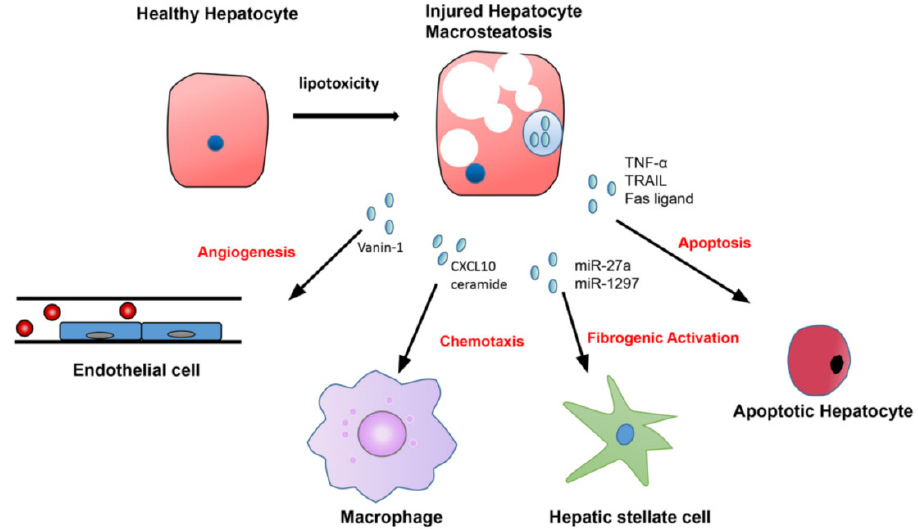
Figure 4. Lipotoxic hepatocytes release numbers of EVs containing specific cargo that contribute to disease processes in NASH. Accumulation of excessive fatty acid in hepatocytes promotes the release of EVs with cargo that promote Vanin ‐ 1 mediated endothelial cell angiogenesis; CXCL10 and ceramides ‐ mediated macrophage chemotaxis; microRNA (such as miR ‐ 27a and miR ‐ 1297) mediated hepatic stellate cell activation, and TNF ‐ a TRAIL and Fas ligand mediated apoptosis of the neighbor hepatocytes .